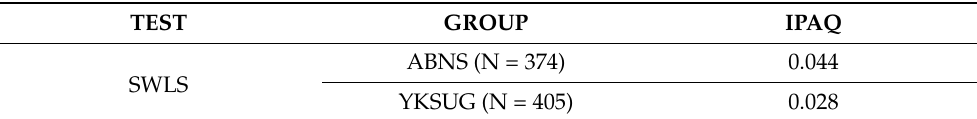
Table 7. Correlations between satisfaction with life and PA in the study participants during COVID-19 pandemic (Spearman’s rho).